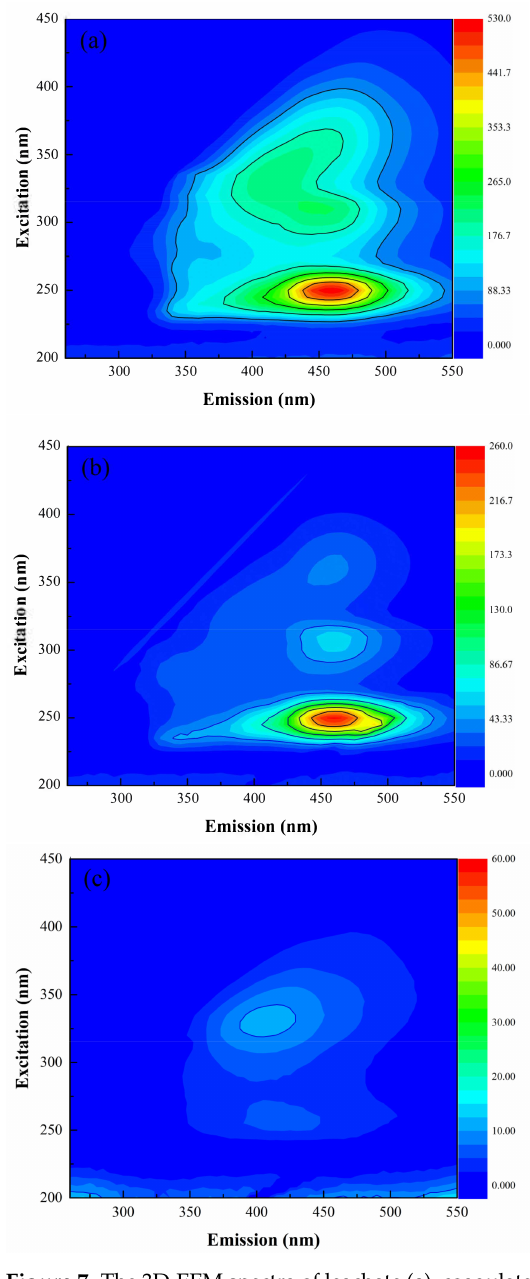
Figure 7. The 3D-EEM spectra of leachate ( a ), coagulated effluent ( b ), and electro-Fe 0 /H 2 O 2 effluent ( c ). Normally, regions I and II are associated with aromatic protein-like substances, and substances in these two regions are easily utilized by microorganisms [5,42]. Region III is associated with fulvic acid-like substances [41]. Region IV is associated with soluble micro- bial byproduct-like material [5]. Region V is associated with humic acid-like organics [42]. As shown in Figure 8, the P i,n of regions III and V in the leachate, totaling 63.12%, indicates that the leachate contains a large amount of humic acid and fulvic acid-like substances. After the coagulation process, the P i,n of region V decreased, and the P i,n of regions I and II increased, indicating that the coagulation process could remove some humic acid sub- stances. After the electro-Fe 0 /H 2 O 2 reaction, the P i,n of regions I and II increased to 37.32%, and the P i,n of regions III and V decreased to 47.58%, indicating that the electro-Fe 0 /H 2 O 2 reaction significantly degraded humic and fulvic acid-like substances in the coagulated effluent, converting them into substances easily used by microorganisms or into CO 2 .